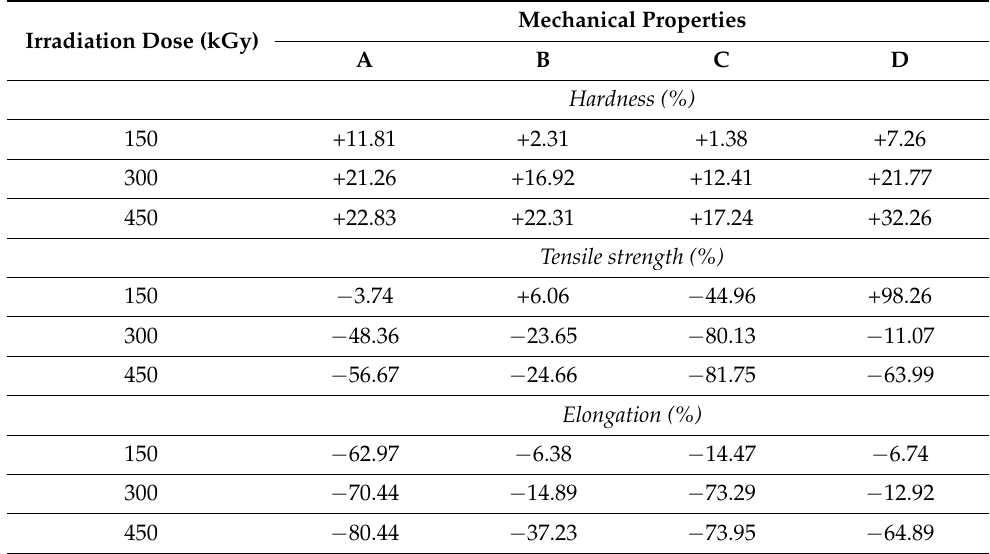
Table 5. Percentage modifications of mechanical properties of the samples after irradiation aging .